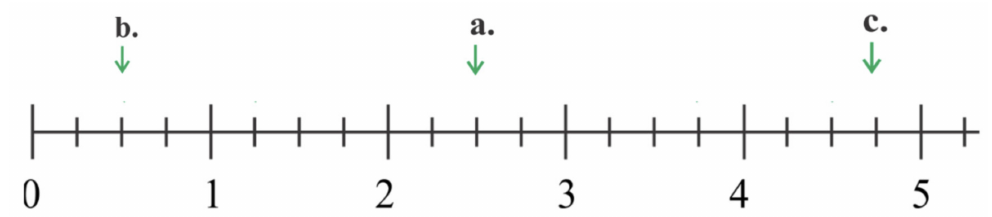
Figure 4. Locating fractions on a number